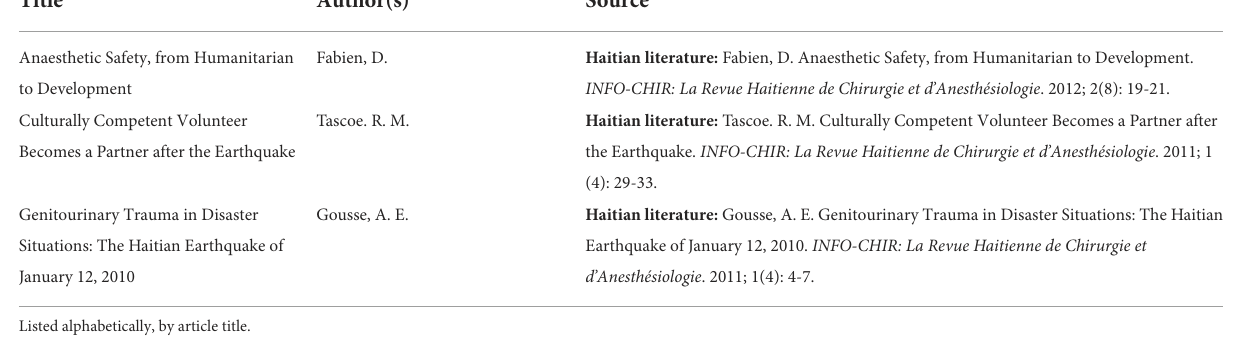
TABLE 5 Citation searches: Articles included.